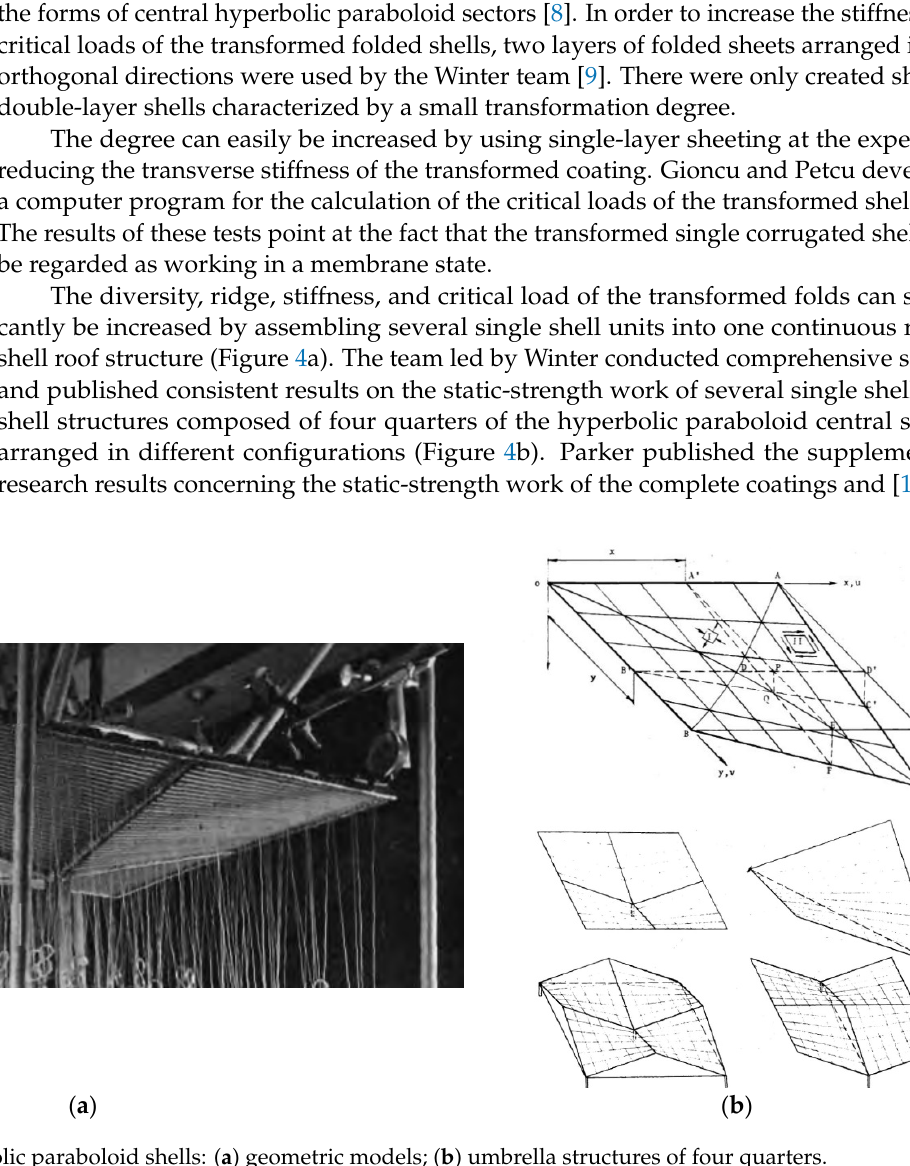
Figure 3. The accurate thin-walled computational mechanical model of a transformed sheet com- posed of four deformed shell folds.